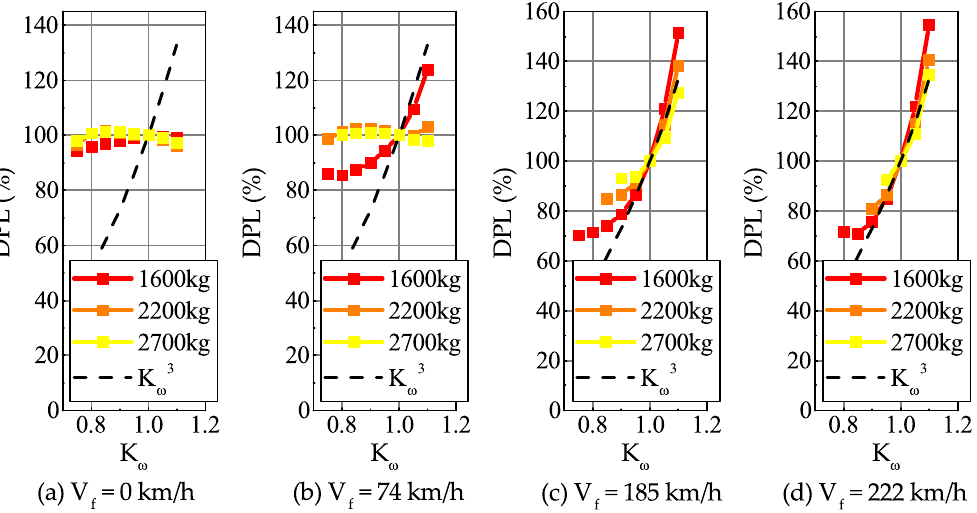
Figure 13. Variation in DPL with rotor speed for different flight